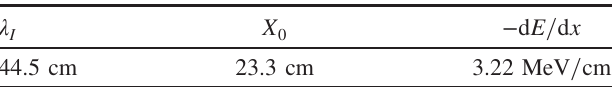
TABLE VII. Inelastic interaction length λ I , radiation length X 0 , and average ionization energy loss − d E= d x of 450 GeV =c protons in graphite used for the scraper blades. Values were computed by FLUKA